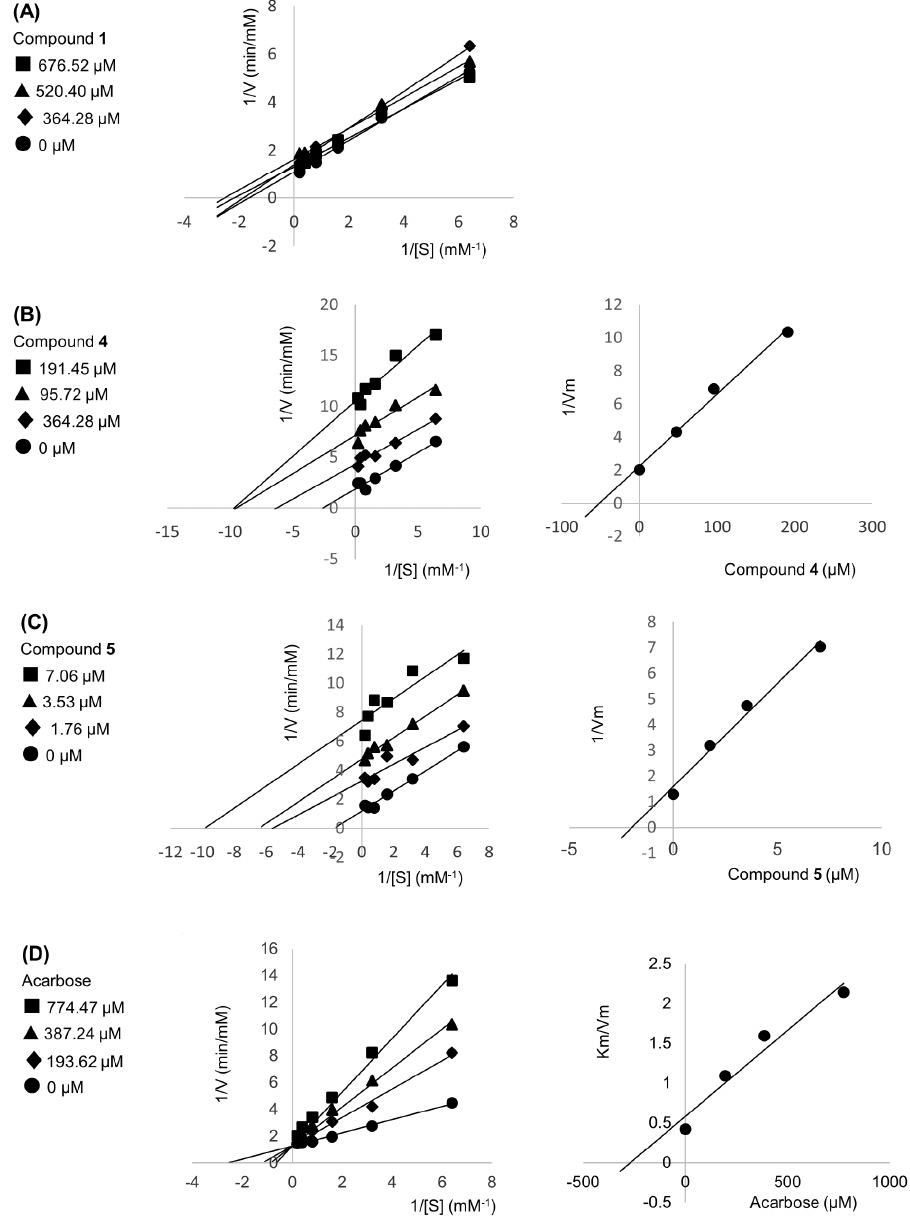
Figure 4. Lineweaver − Burk plots of compound 1 , 4 , 5 , and acarbose, respectively ( A – D ). The secondary plots of each compound are on the right.